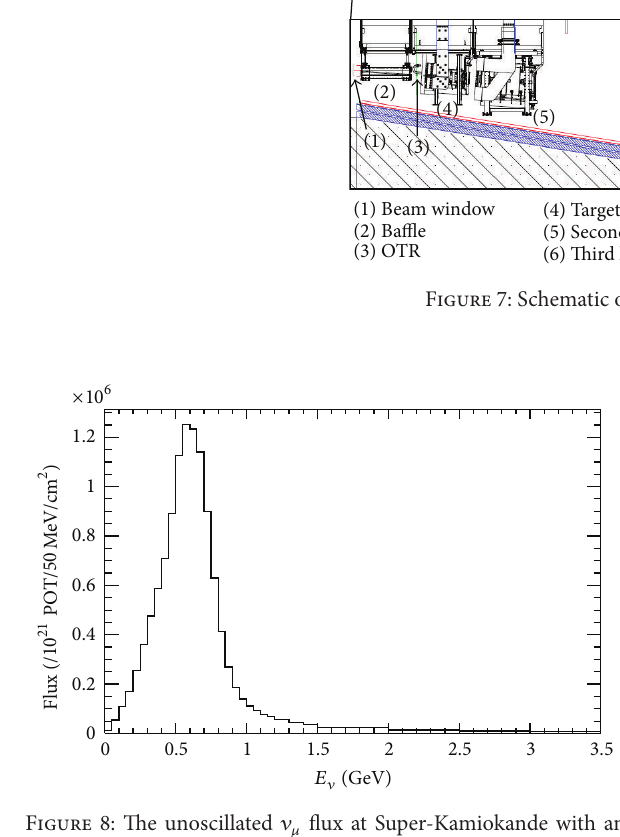
Figure 8: The unoscillated 𝜈 𝜇 flux at Super-Kamiokande with an off-axis angle of 2.5 ∘ and operation of the electromagnetic horns at 250